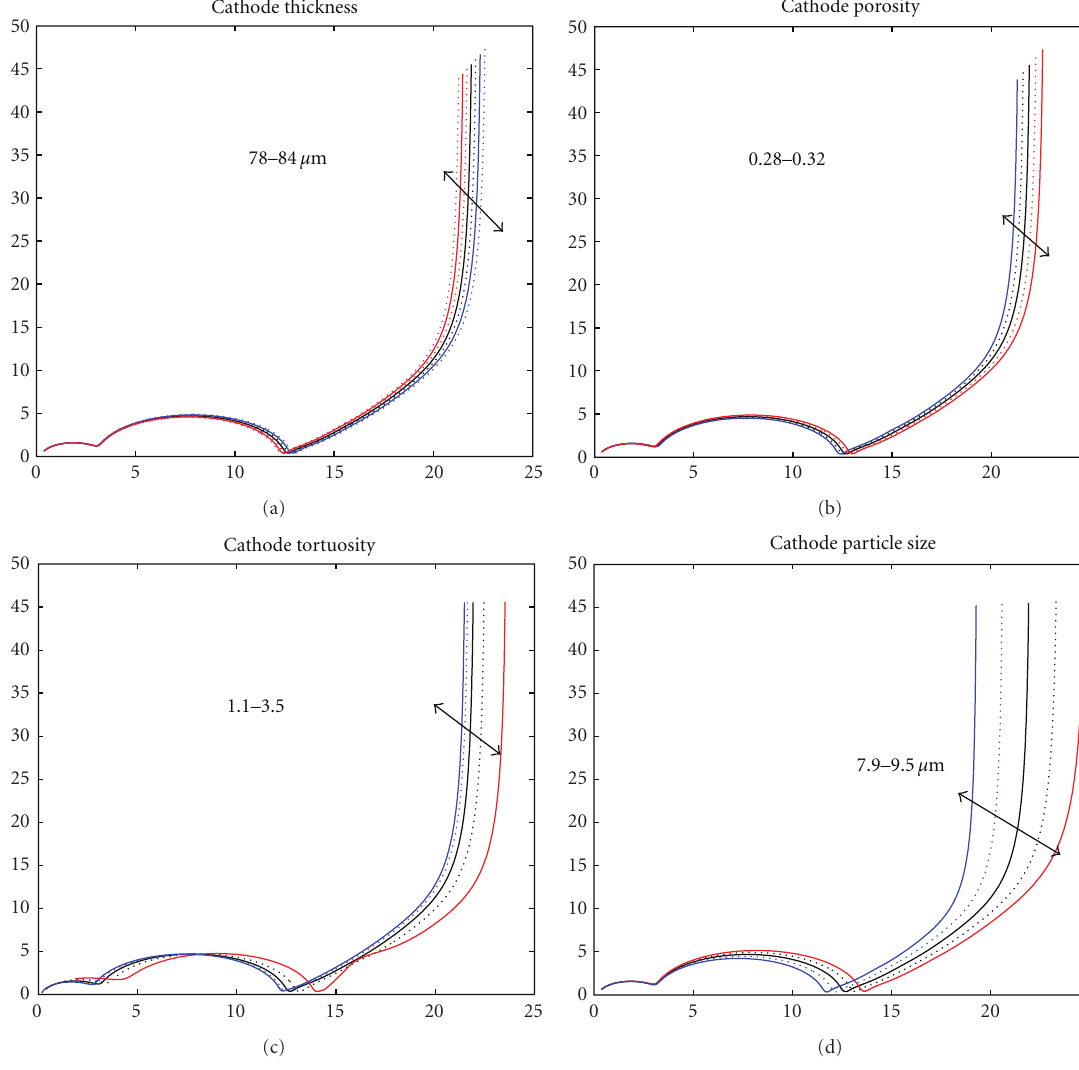
Figure 4: Sensitivity analysis on the cathode: plotted are the Nyquist responses when the design parameters at the cathode are swept about their corresponding nominal values, within the range of manufacturing